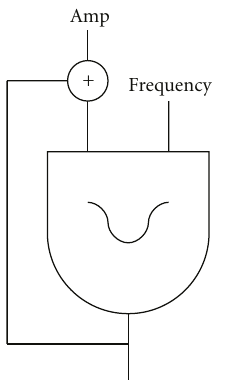
Figure 1: Feedback AM oscillator